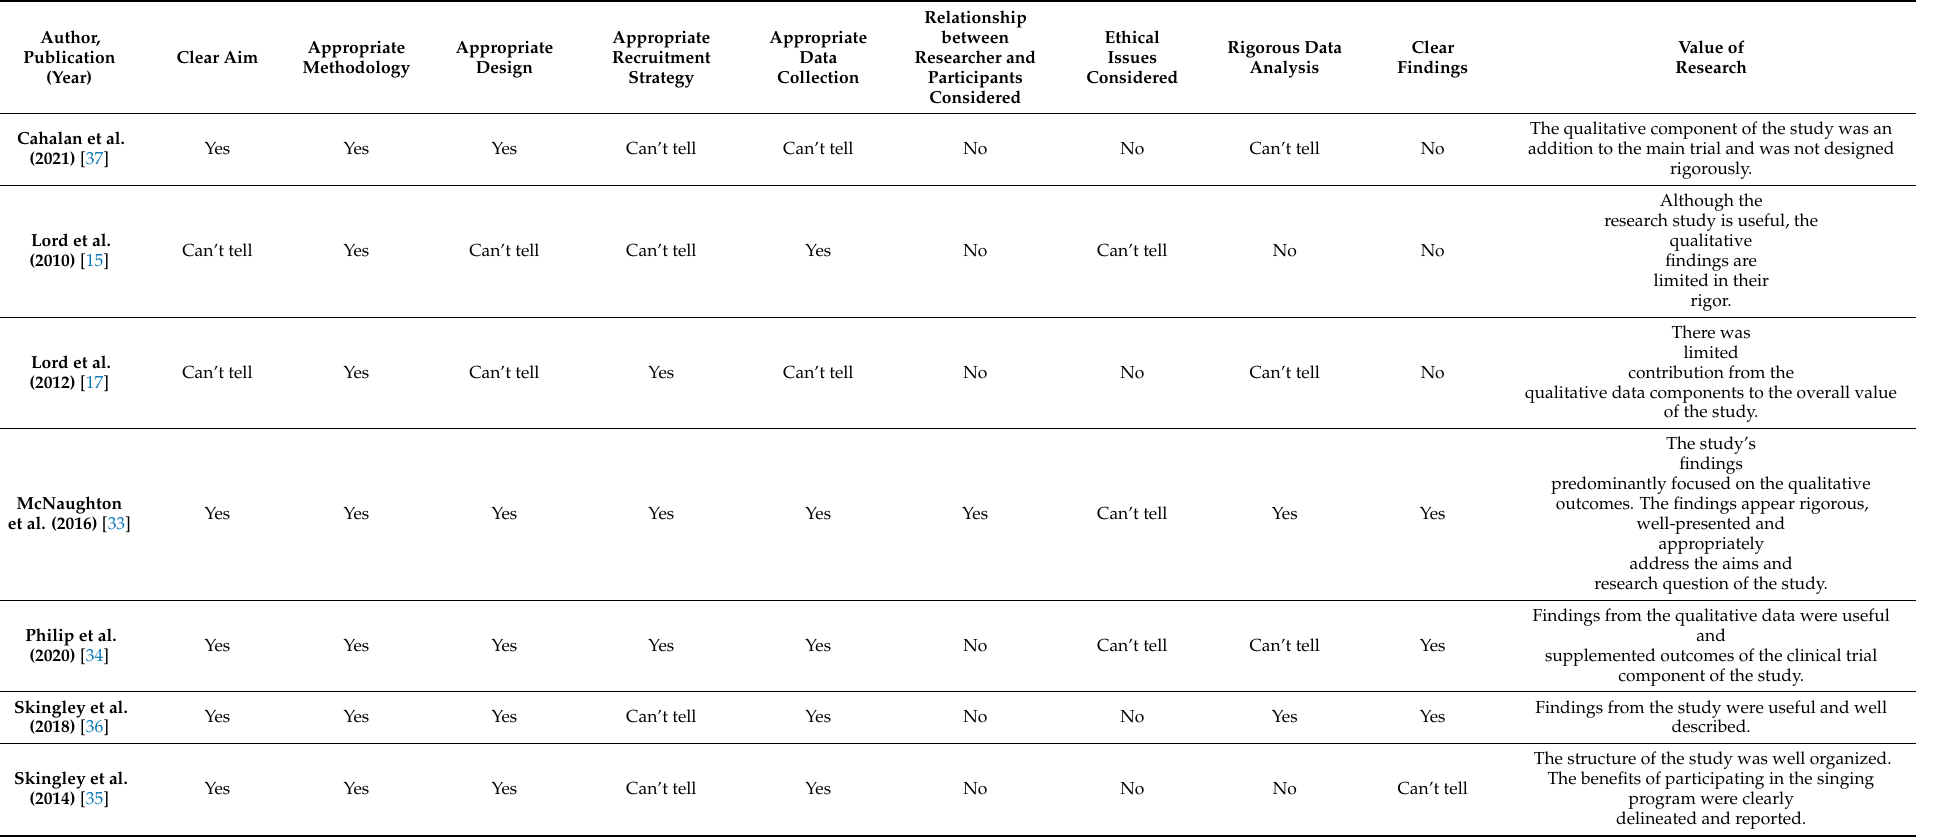
Table A1. Critical Appraisal Skills Program Checklist